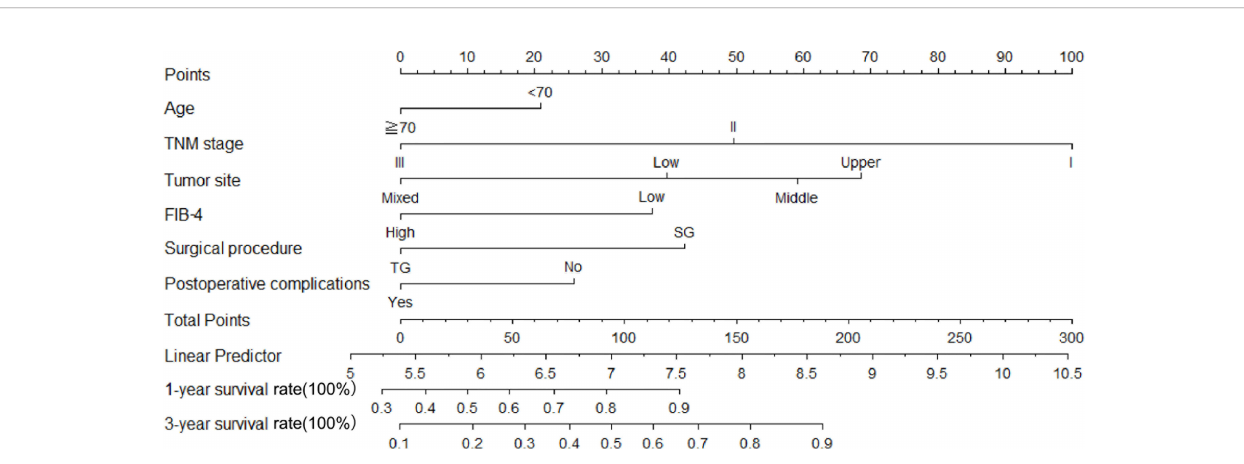
FIGURE 2 | A nomogram indicating the survival. An example of a nomogram — Draw an upward vertical line from the covariate to the points bar to calculate points. Based on the sum of the covariate points, draw a downward vertical line from the total points line to calculate survival